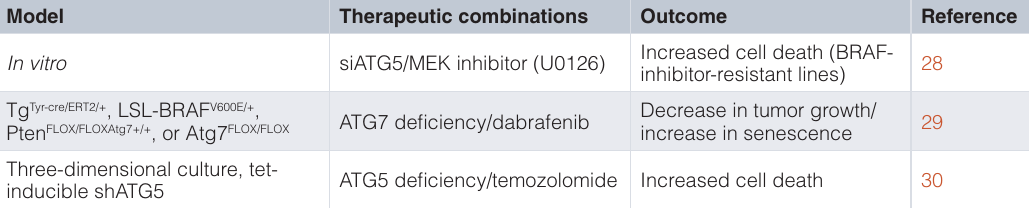
Table 1. Strategies to inhibit autophagy and increase drug-induced death in